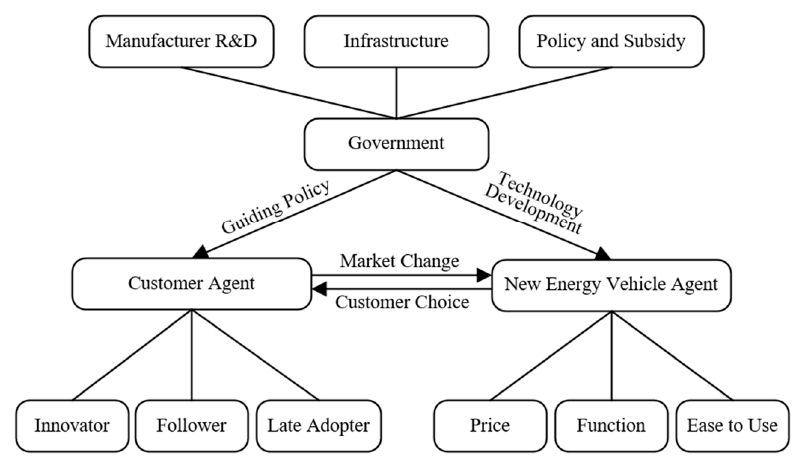
Figure 5. Framework of new energy vehicle market diffusion model.